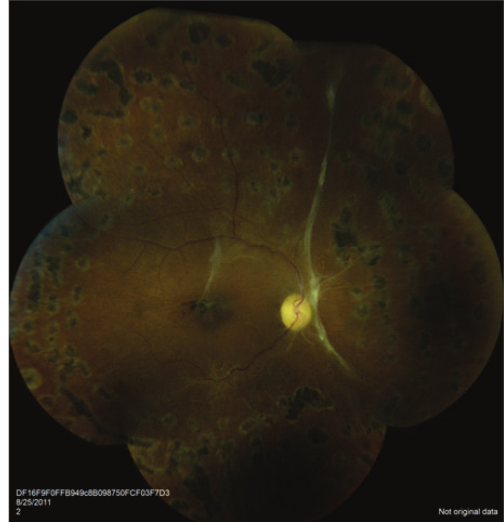
Figure 2: Fundus photograph demonstrating severe retinal vas- culitis. Significant ischemia is present which is highlighted by the attenuated and sclerotic vasculature. Panretinal photocoagulation was required to treat ischemic and neovascular complications.